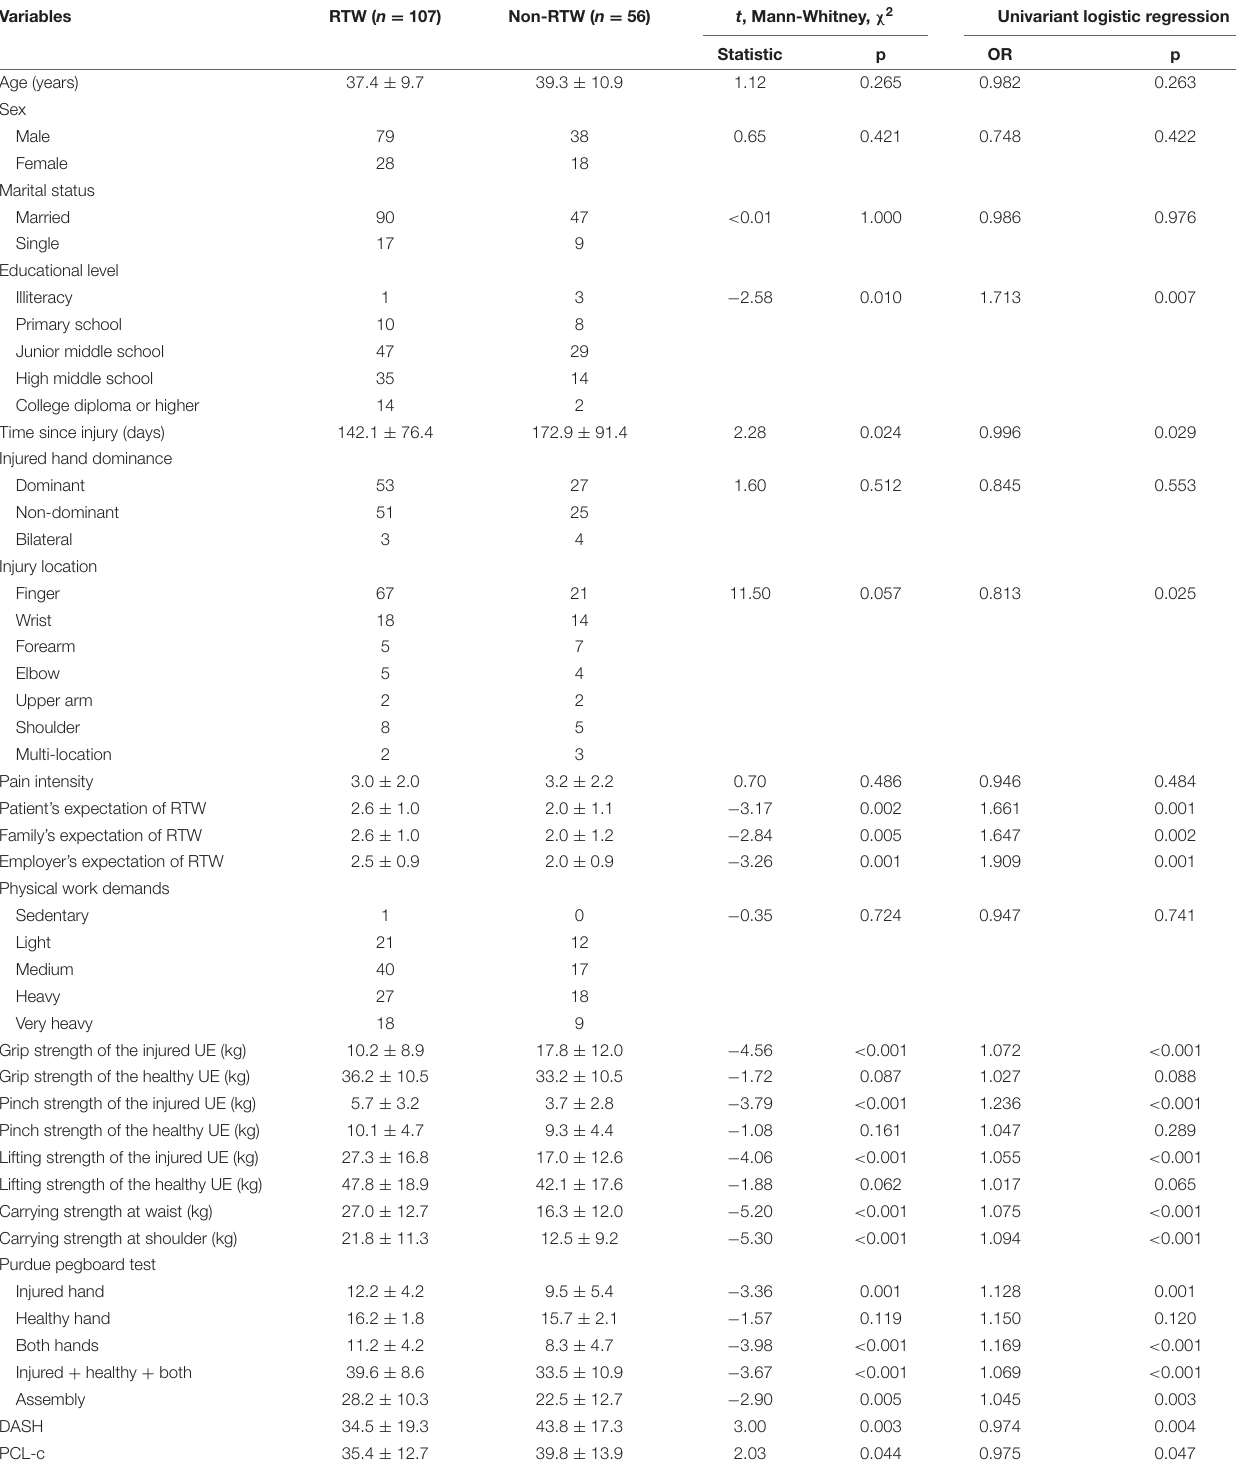
TABLE 1 | Univariant logistic regression result comparison between RTW and non-RTW patients.